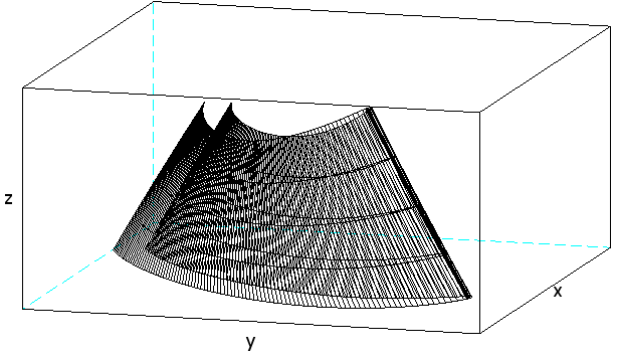
Figure 6. Pressure side and suction side of the blade after applying the thickness function.